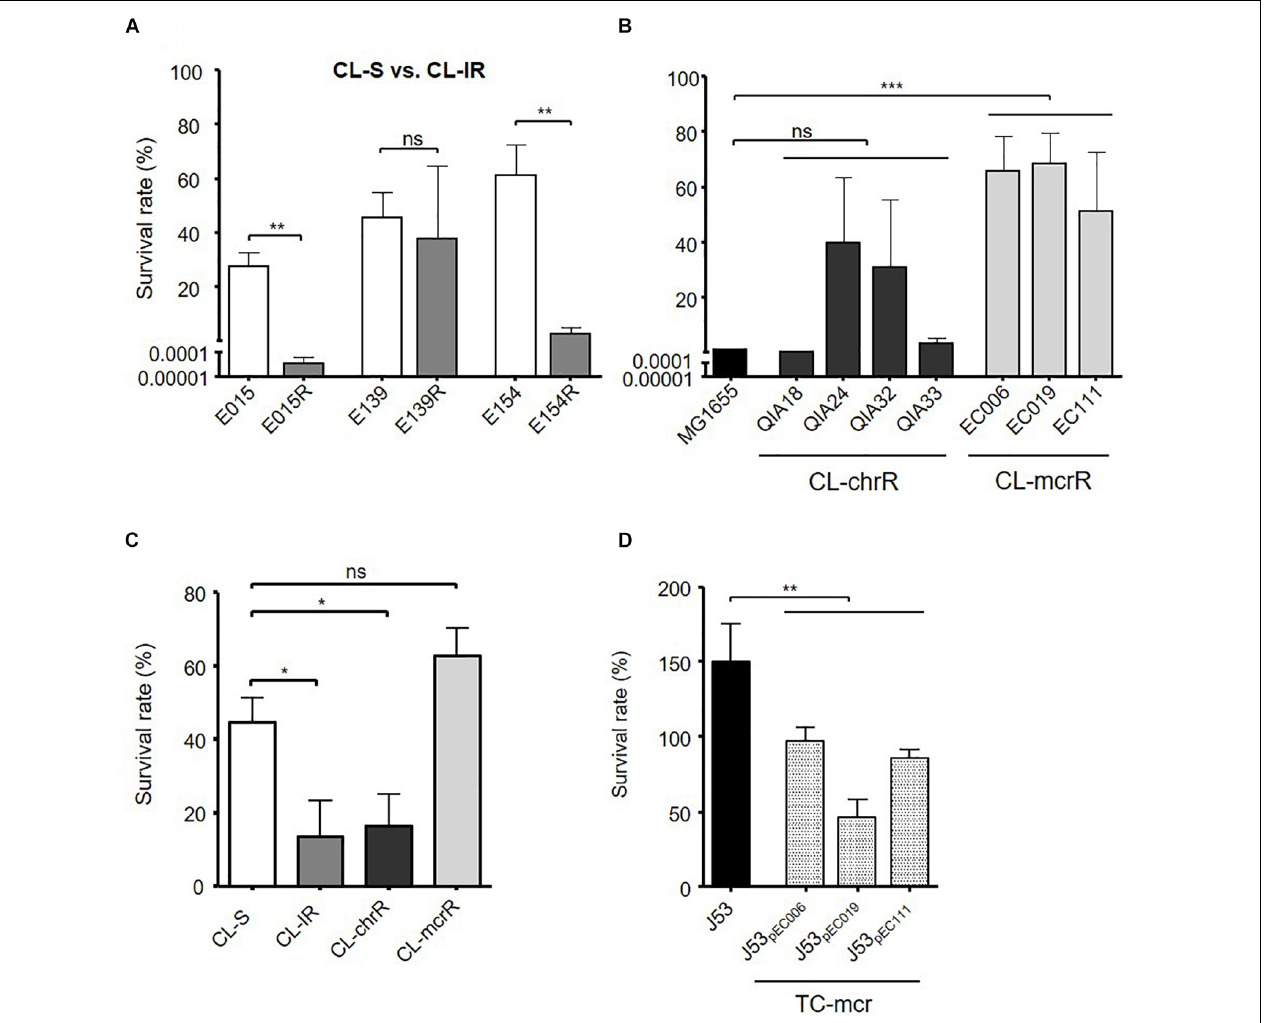
FIGURE 5 | Results of serum resistance assay. (A) Comparison of survival rates in human serum between CL-S and CL-IR strains. (B) Survival rates of CL-chrR and CL-mcrR strains in human serum were compared with that of E. coli reference strain MG1655. (C) Comparison of survival rates in human serum among CL-S, CL-IR, CL-chrR, and CL-mcrR strains. (D) Survival rates of TC-mcr strains in human serum were compared with that of their recipient strain, J53. The error bars indicate the standard deviations. Statistics were conducted with unpaired, two-tailed t -tests. * P ≤ 0.05; ** P ≤ 0.01; *** P ≤ 0.0001; ns, not